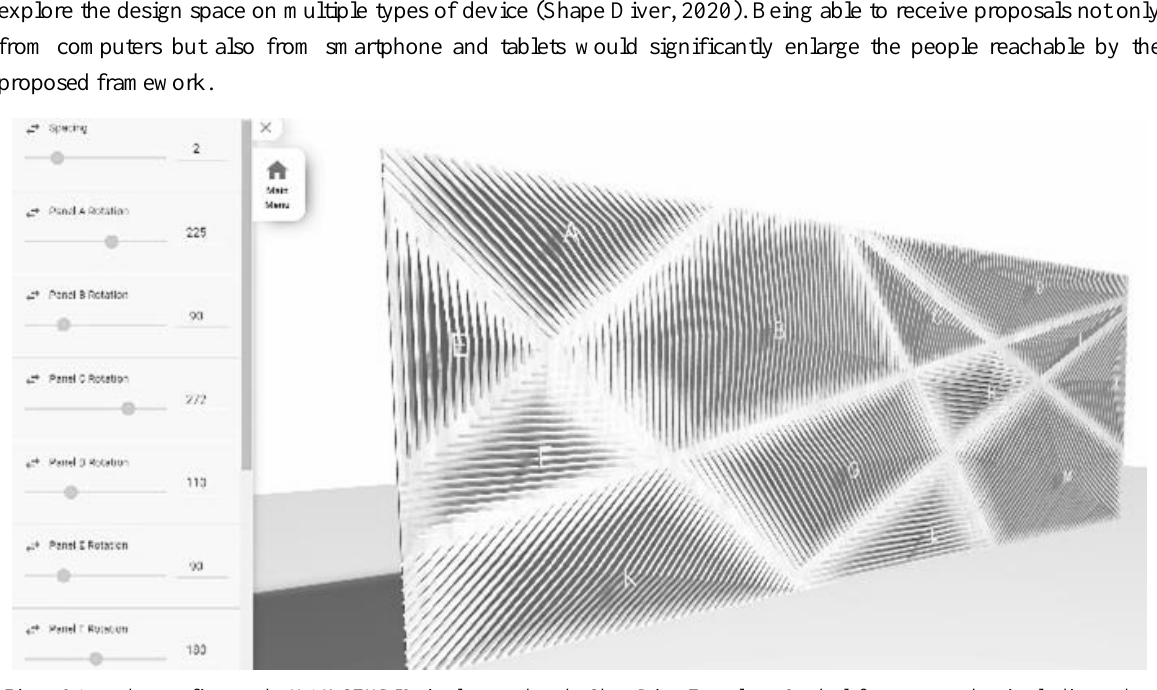
Figure 3 A product configurator by MAK STUDIO, implemented on the ShapeDiver Tecnology. On the left we can see the visual editor and on the right the real time 3d visulization. Available on